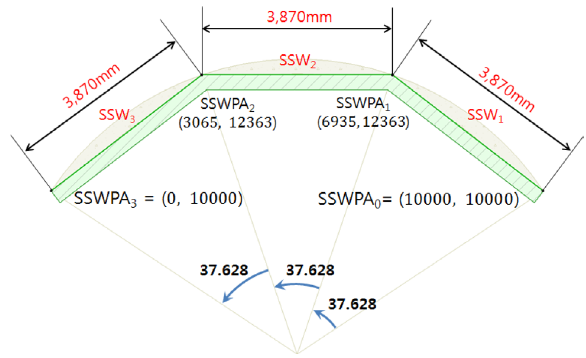
Fig. 16. Representation data of model A’ with SSW n